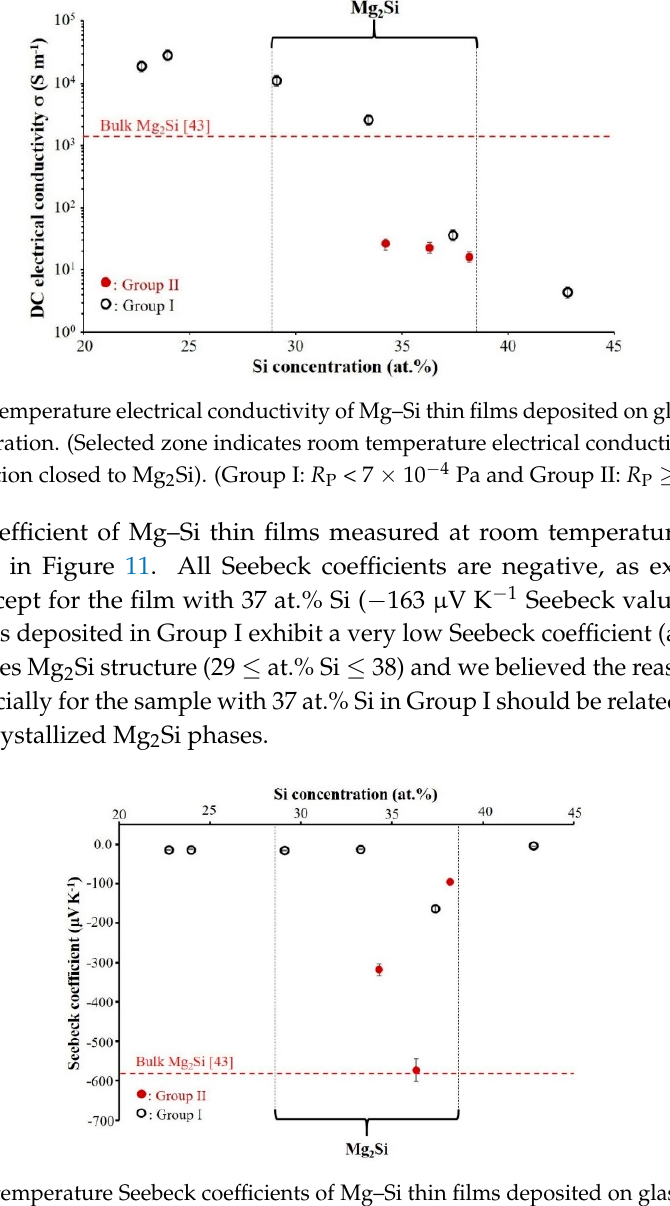
Figure 11. Room temperature Seebeck coefficients of Mg–Si thin films deposited on glass substrate as a function of Si content. (Selected zone indicates room temperature Seebeck coefficients of coatings with the composition closed to Mg 2 Si). (Group I: R P < 7 × 10 − 4 Pa and Group II: R P ≥ 7 × 10 − 4 Pa).